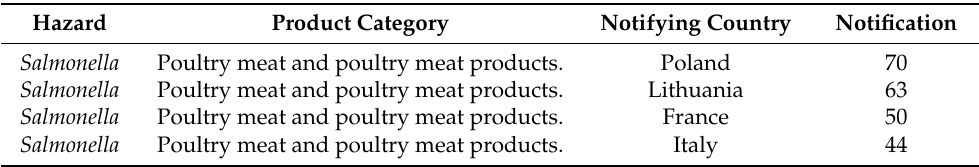
Table 2. Number of notifications counted for each combination of hazard/product category/notifying country.